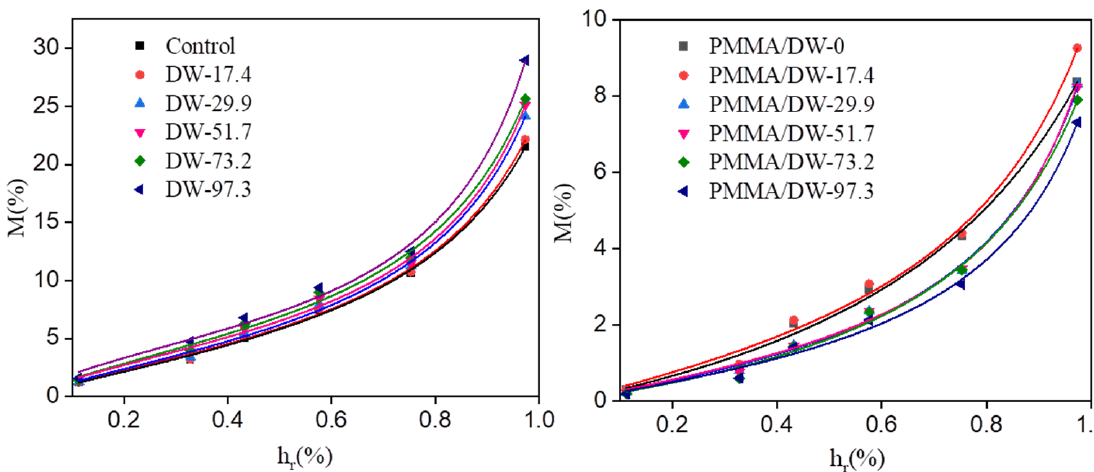
Figure 4. The results of the fitting of studied experimental data by the GDW model. Table 4. The values of the best fit parameters obtained from the fitting of experimental data by the GDW model.